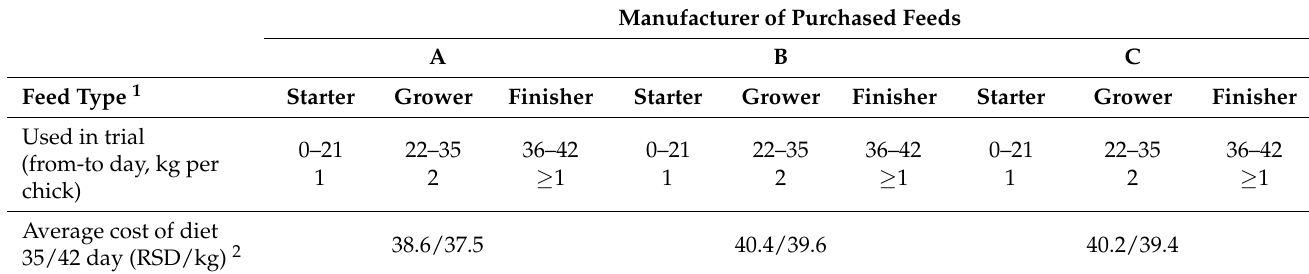
Table 7. Characterization of feed for broilers purchased on the Serbian market after biological